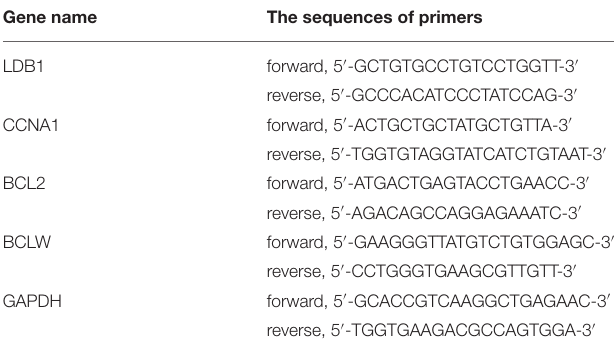
TABLE 1 | The primers used in the